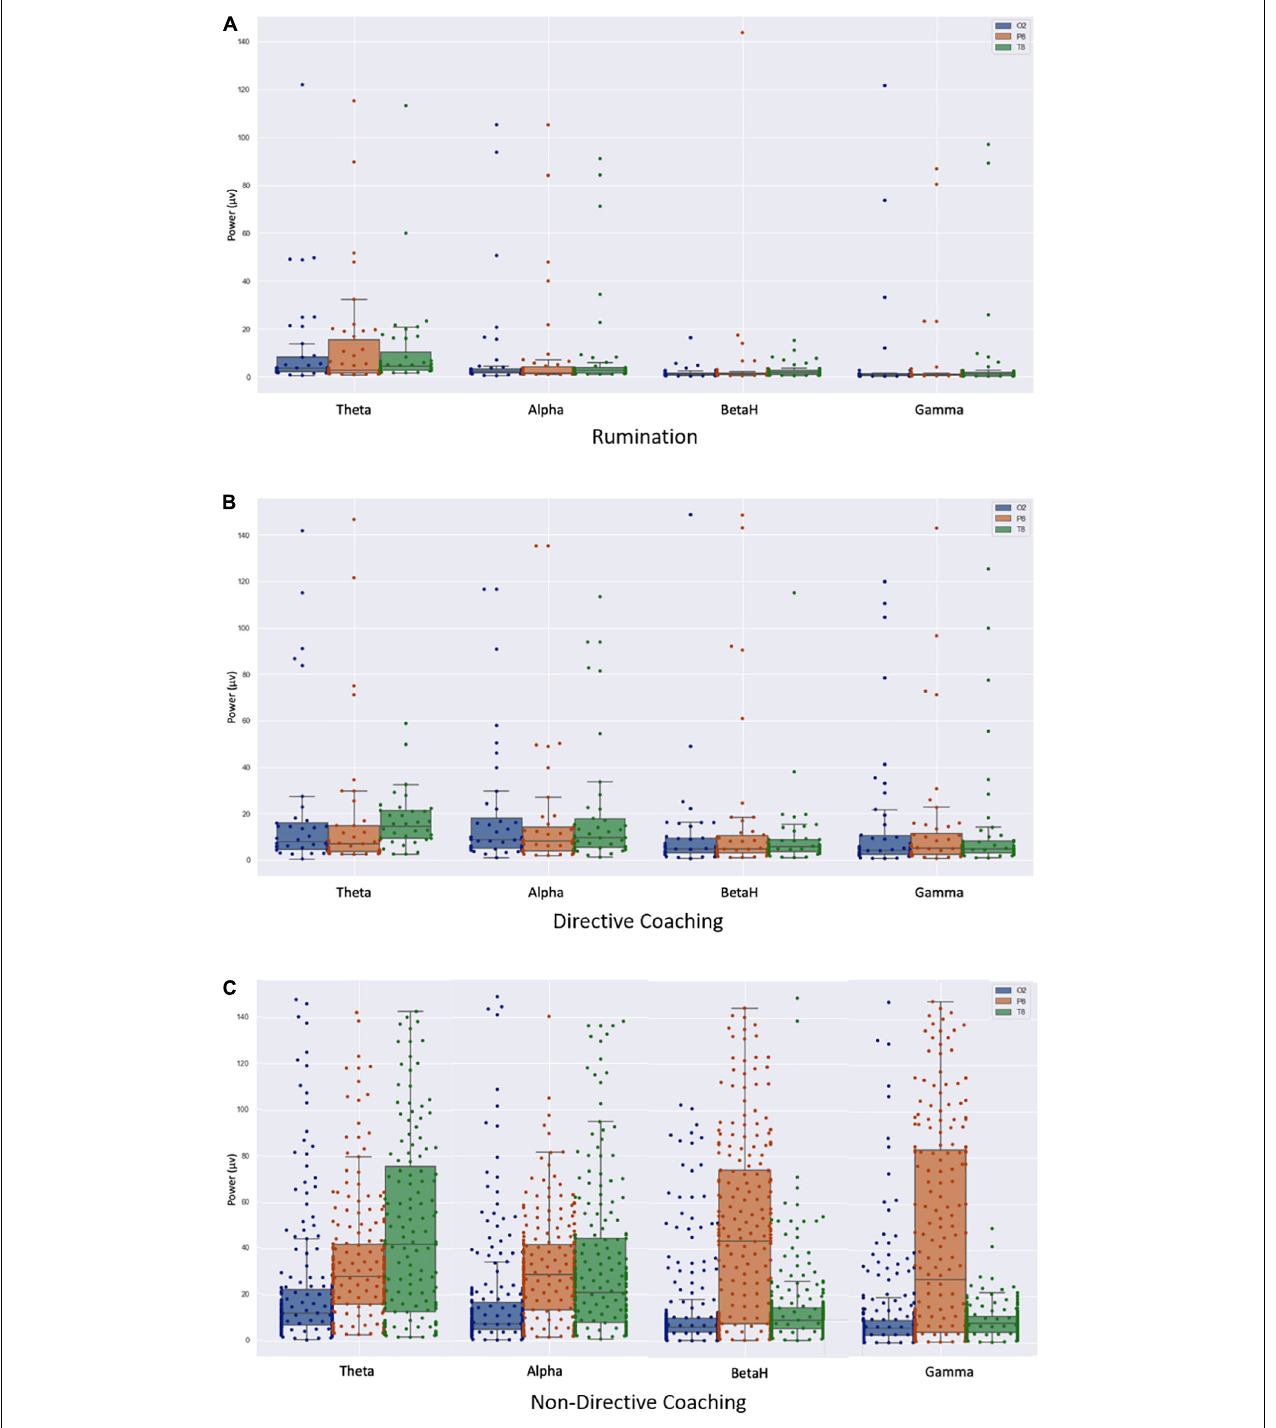
FIGURE 4 | Box plots represent medians, interquartile ranges (P25–P75), and min-max (whiskers) of the EEG power during insight time window (epochs) in occipito-parieto-temporal right channels in each experimental condition [ (A) Rumination, (B) Directive coaching, and (C) Non-directive coaching]. The graphic shows the distribution of the EEG power associated to insights in the right occipital (blue), parietal (orange), and temporal (green) channels at the theta, alpha, beta high, and gamma frequency ranges during each condition. Creative insights during non-directive coaching condition induced higher EEG power in the alpha and theta frequency bands of the right temporal region (T8), and in the alpha, theta, and gamma frequency bands of the right parietal region (P8). No differences were found in the right occipital region (O2). Within the box, black line represents the median value. Color data points are shown for each selected channel (blue to occipital, O2; orange to parietal, P8; green to temporal,